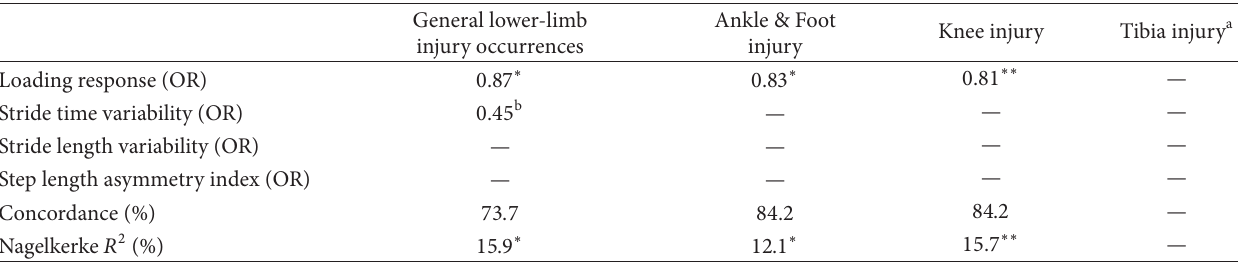
Table 3: Summary of binary logistic regression analyses with backward elimination